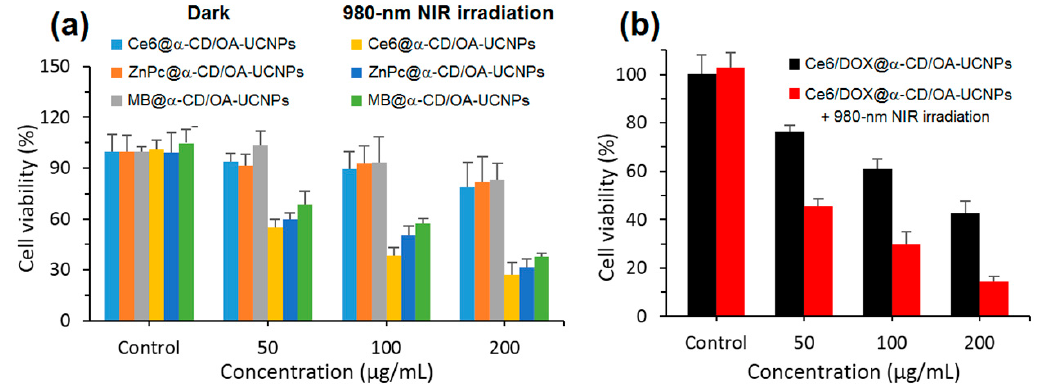
Figure 54. Dark and photoinduced ( λ = 980 nm, 1 W/cm 2 for 5 min) mortality of A549 cells treated with ( a ) α -CD/OA-UCNPs as control, Ce6@ α -CD/OA-UCNPs, ZnPc@ α -CD/OA-UCNPs, MB@ α -